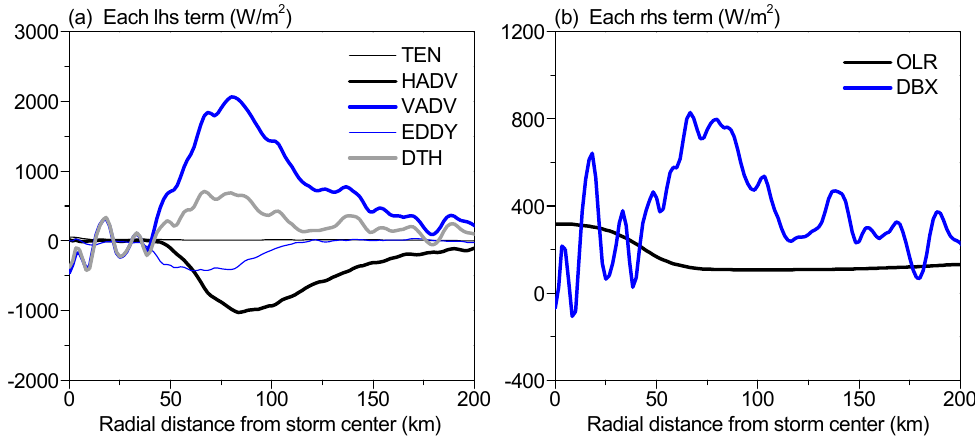
Figure 8. As in Figure 7, but for the upper-troposphere MSE budget for ( a ) lhs and ( b ) rhs terms. Vertical integral is taken from 10 km to the top of the model atmosphere.